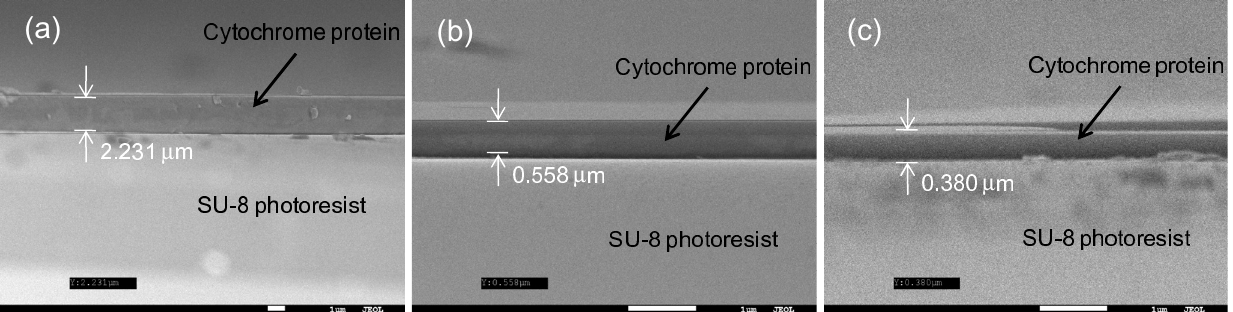
Figure 5. SEM pictures of the protein layer on top of the SU-8 photoresist mesa after ( a ) 3 min, ( b ) 6 min, and ( c ) 10 min UV/ozone usage